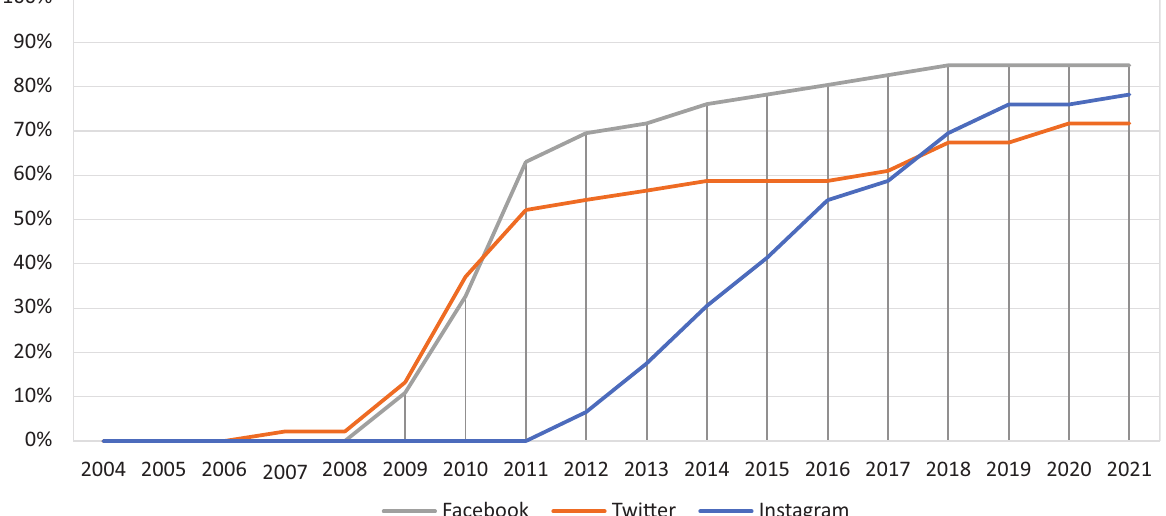
Figure 1. Adoption of Facebook, Instagram, and Twitter among Swiss HEIs. Note: Yearly percentage of HEIs on Facebook, Instagram, and Twitter from 2004 until